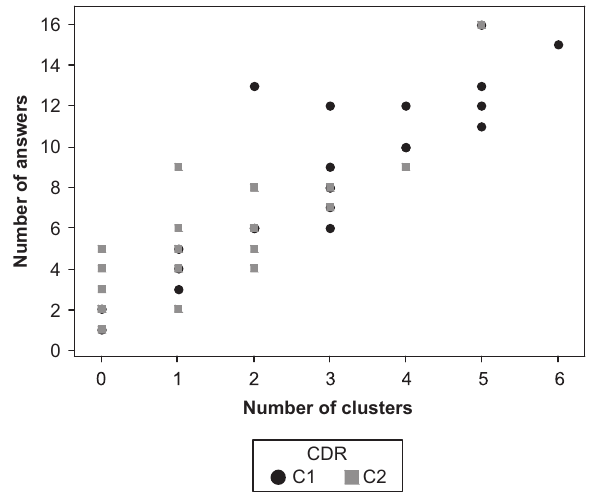
Figure 1. Correlation of number of clusters and number of answers.